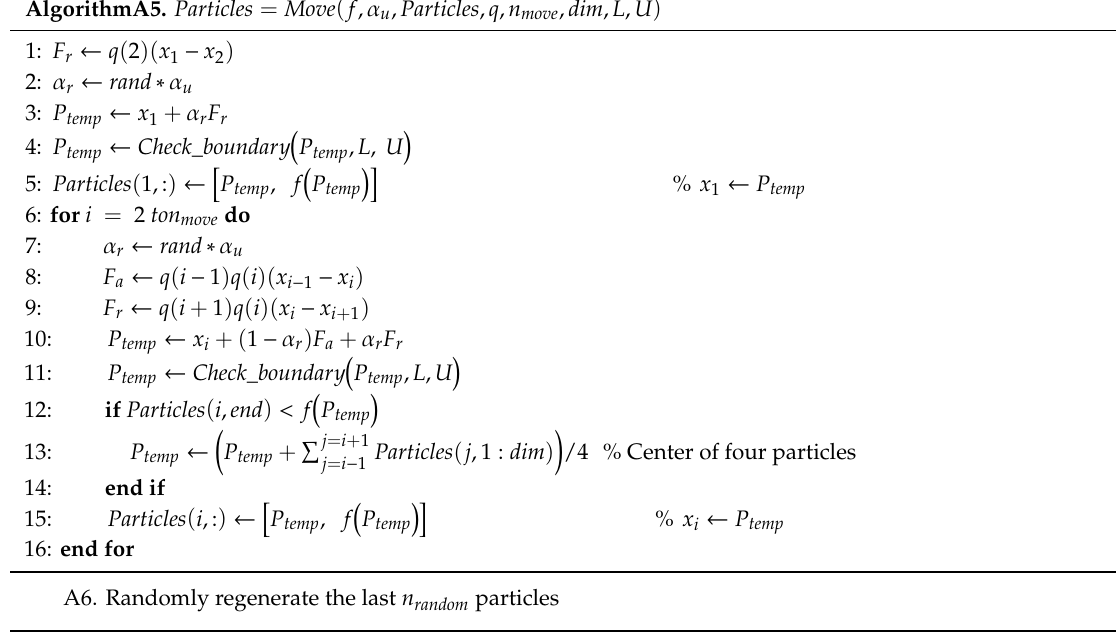
AlgorithmA6. Particles = Random _ regenerarte ( f , Particles , n move , L , U )